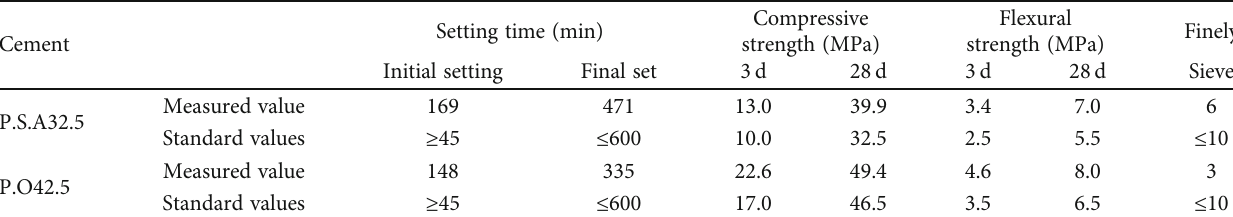
Table 1: The main physical properties of cement table.